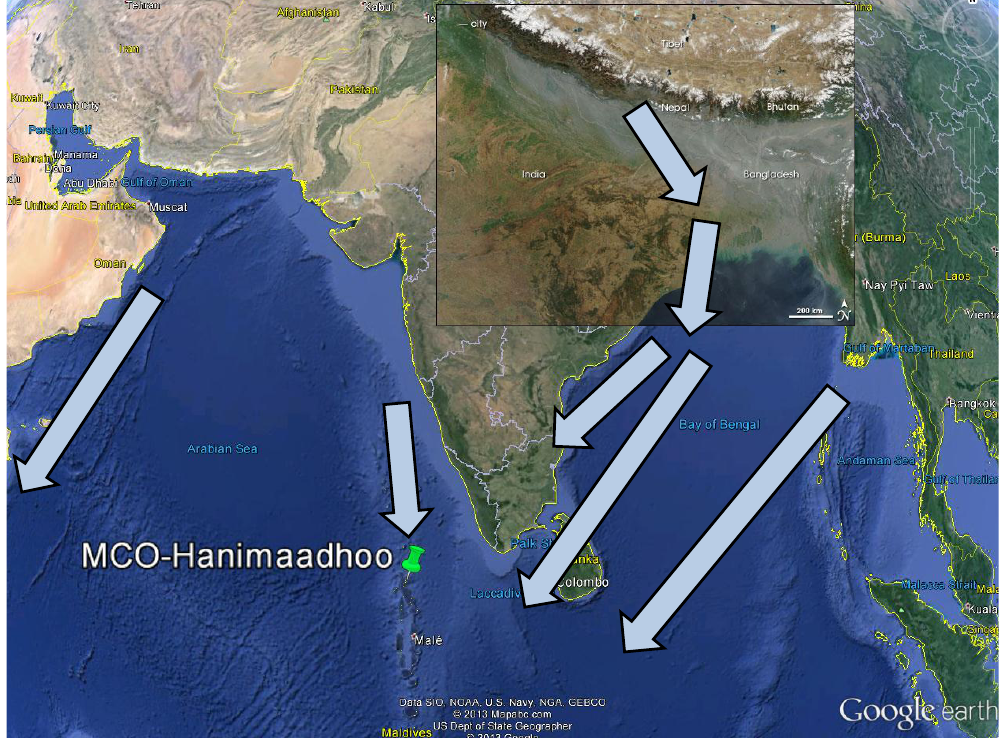
Figure 1. Map of the study location highlighting the Maldives Climate Observatory at Hanimaadhoo (MCOH). The overlay is a NASA MODIS satellite image of the region, showing an aerosol plume coming off the subcontinent. The presence of absorbing aerosols in the plume is evident from its greyish color. Predominant low-level flow during winter months (Lawrence and Lelieveld, 2010) is indicated by the